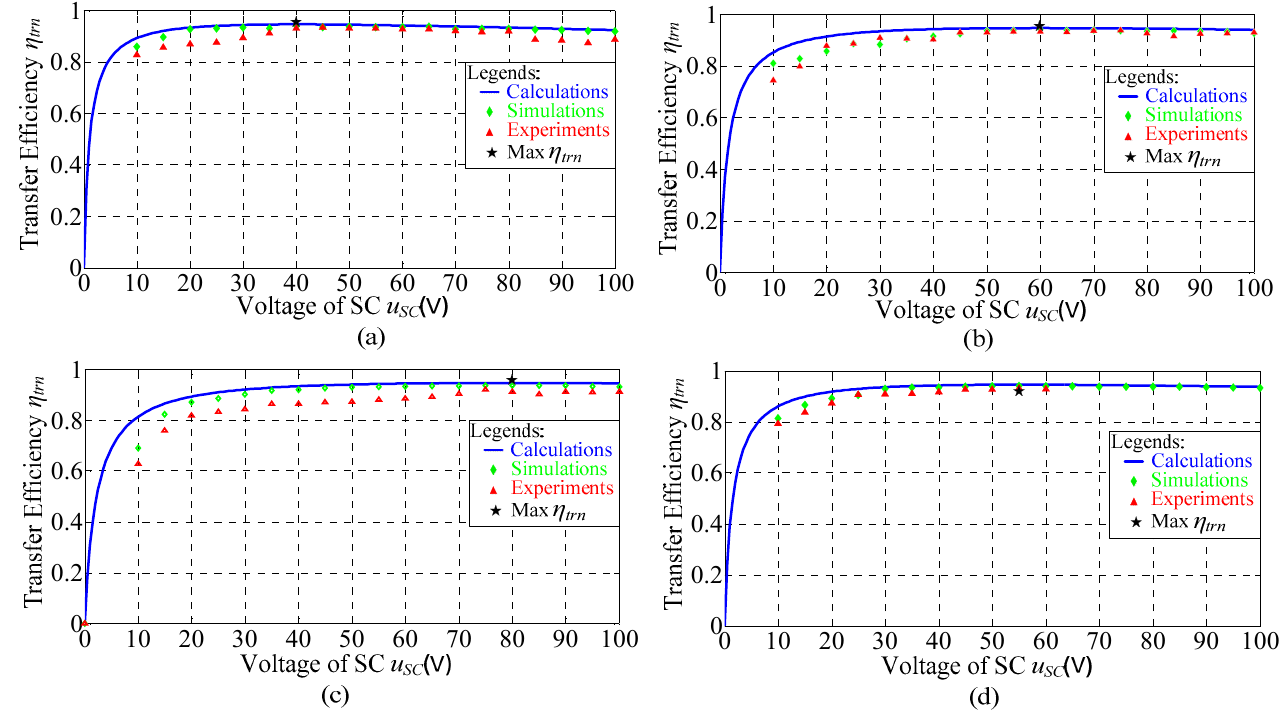
Figure 16. Curves of the transfer efficiency: ( a ) U BUS = 40 V, α = 0°; ( b ) U BUS = 60 V, α = 0°; ( c ) U BUS = 80 V, α = 0°; ( d ) U BUS = 60 V, α = 45°.